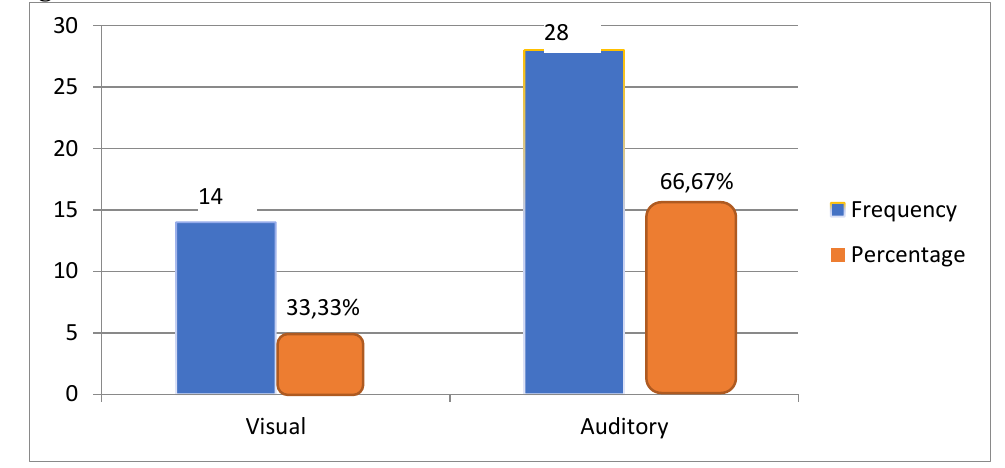
Figure 1. The Frequency of the Distribution of Students’ Learning